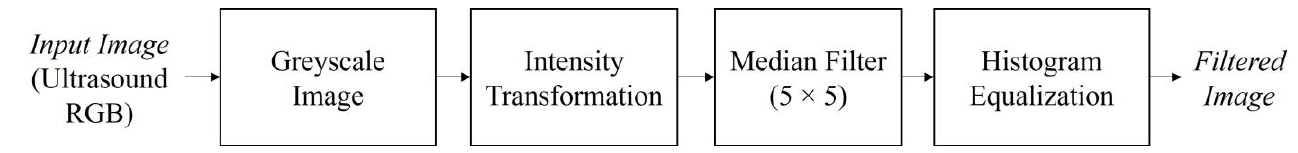
Figure 6. Pre-processing steps of the ultrasound image before the image segmentation step.